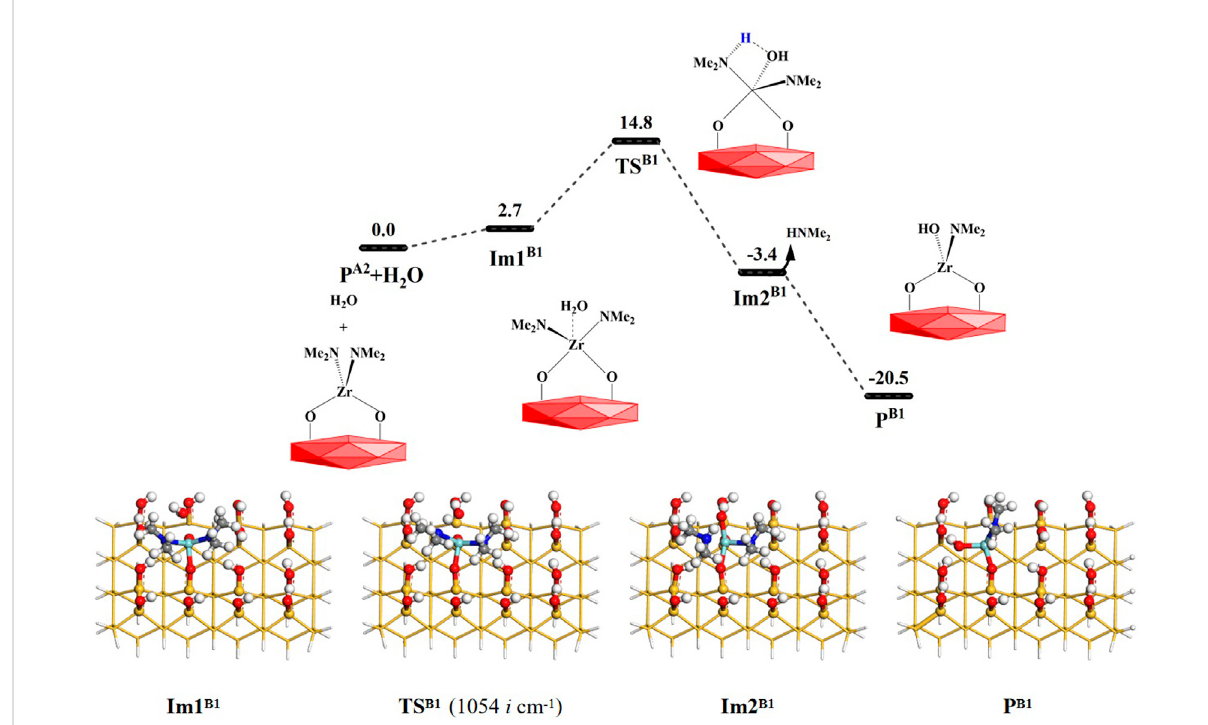
FIGURE 5 Gibbs free energy ( Δ G , kcal/mol) pro fi les of the B1 section of the H 2 O reaction with the aminated surface.